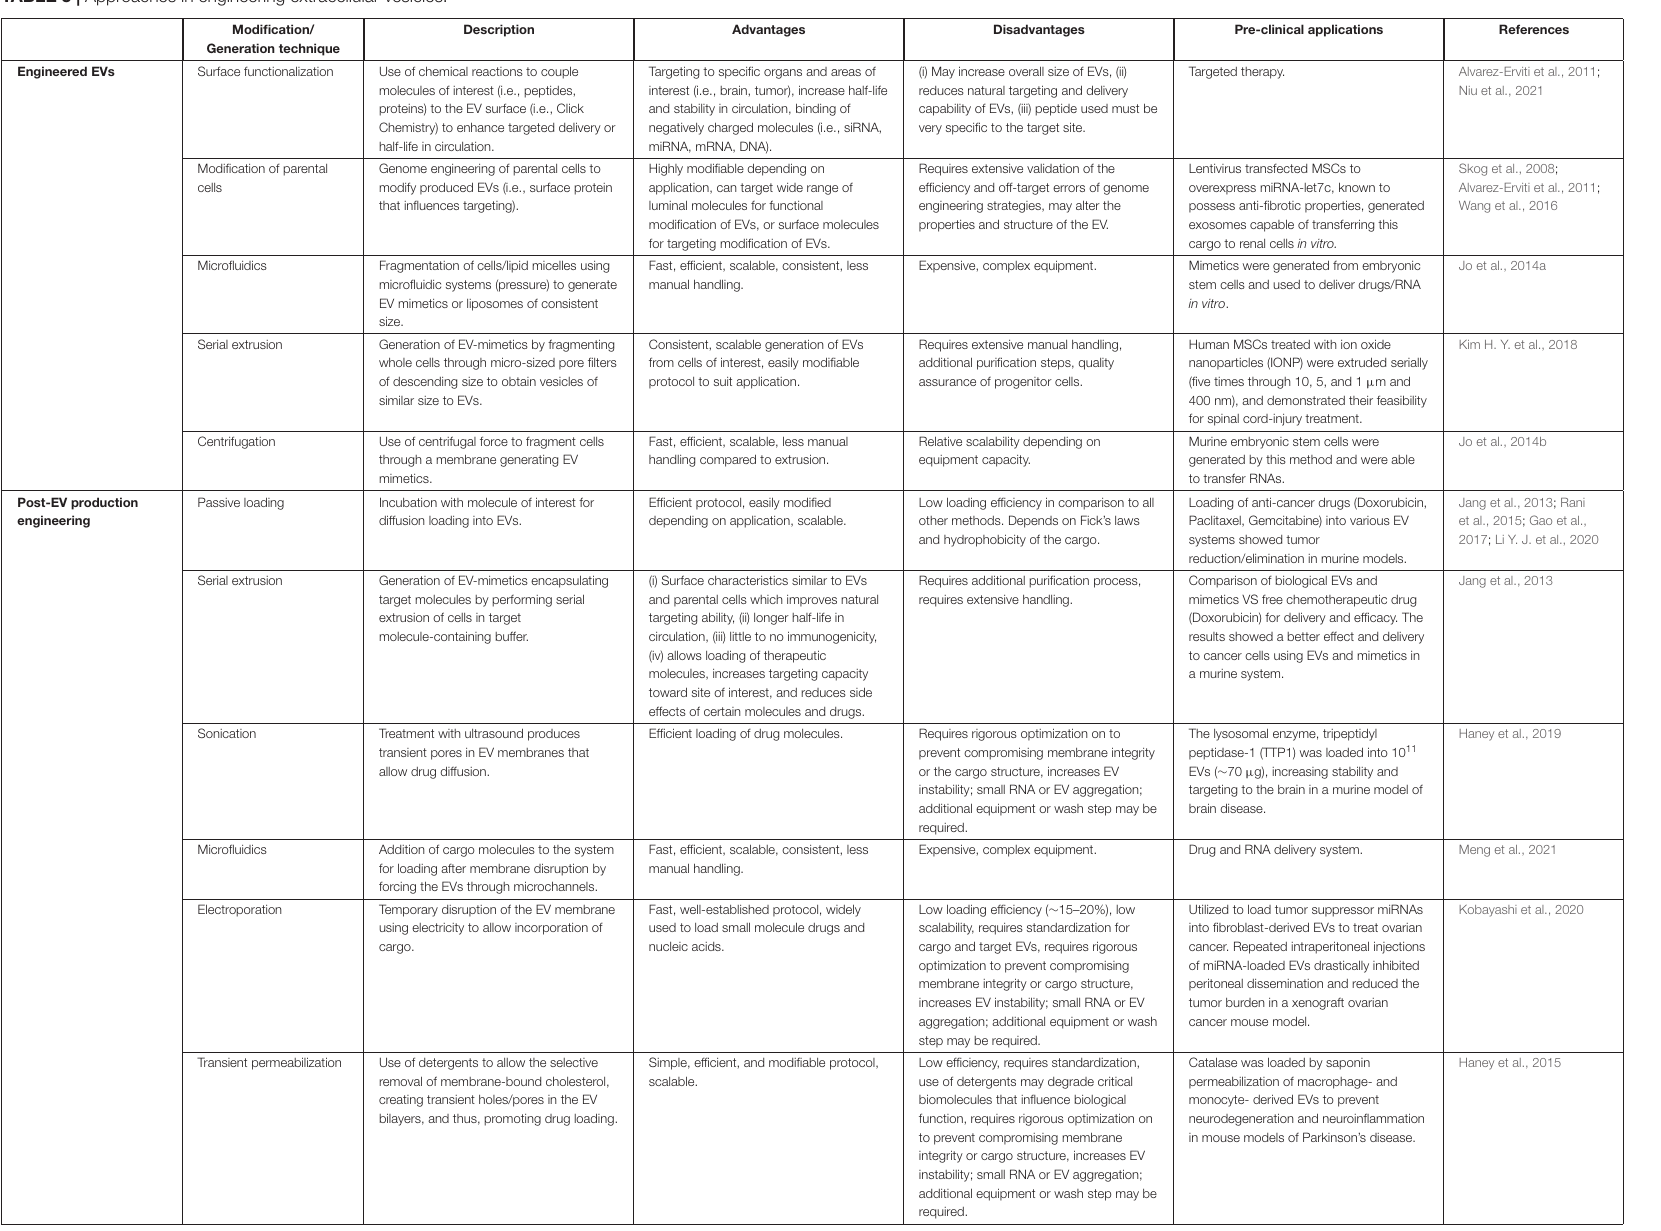
TABLE 3 | Approaches in engineering extracellular